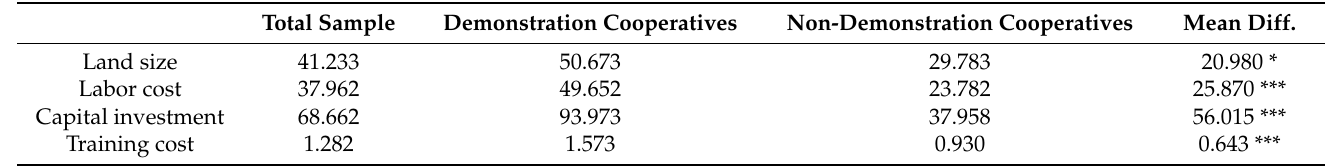
Table 2. Comparison of the mean difference between the input of production factors of demonstration cooperatives and non-demonstration